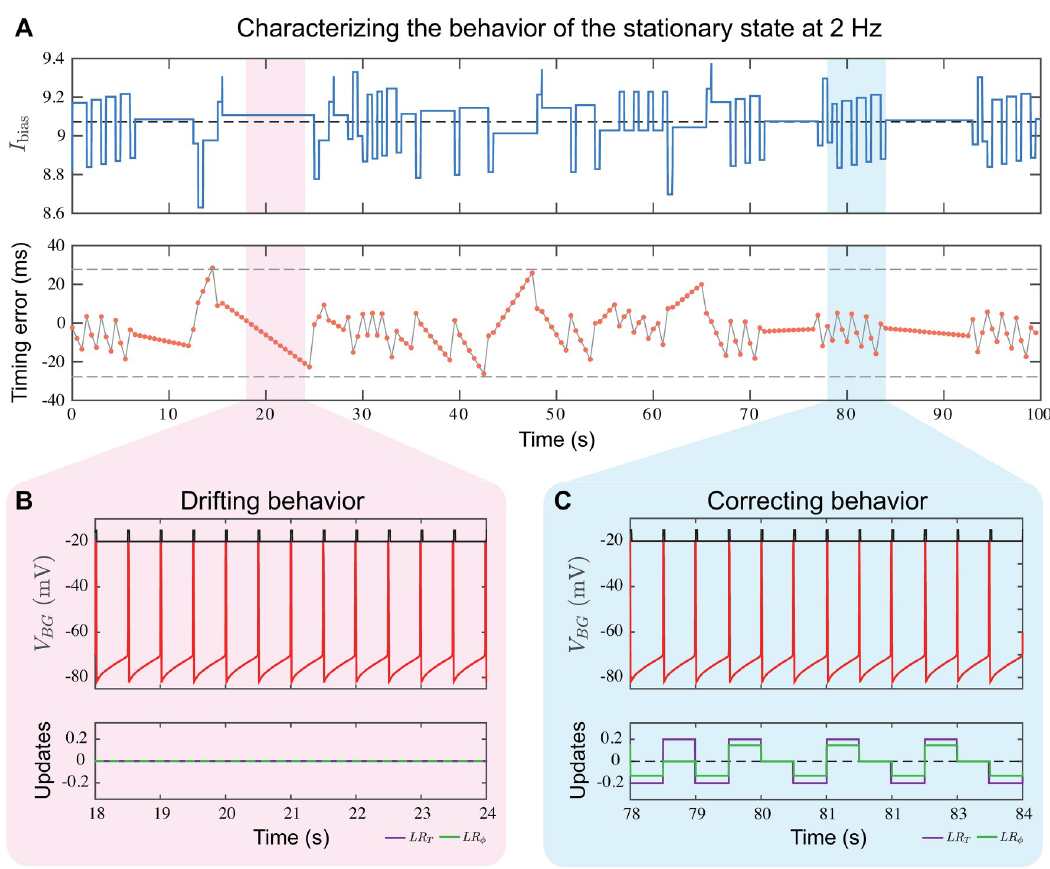
Fig 5. Characteristics of stationary behavior. The BG alternates between drifting and corrective behavior while maintaining a beat within one gamma cycle accuracy for a 2 Hz stimulus. A . The upper time course of I bias shows intervals of rapid change interspersed with intervals of no change. In both cases, I bias is centered near I bias = 9.06 (dashed line) representing the value that produces exactly 2 Hz oscillations. The lower time course shows the timing error differences, S spike time subtracted from BG spike times. Intervals of rapid change intermingle with intervals of slower constant change, corresponding to the intervals of rapid changes and no change, respectively, in the upper panel. Timing errors never exceed a time interval of one gamma cycle, ± 27.73 ms shown by the dashed grey lines. B . Drifting behavior in a 6 s interval shows no updates due to the learning rules during this time. The BG spikes systematically advance relative to stimulus onset times, consistent with the negative slope seen in pink in panel A (lower). C . and LR help maintain the 2 Hz oscillation. These Corrective behavior in a different 6 s interval shows how the learning rules LR T ϕ rules are invoked whenever the counts γ BG or CC BG do not match with γ S